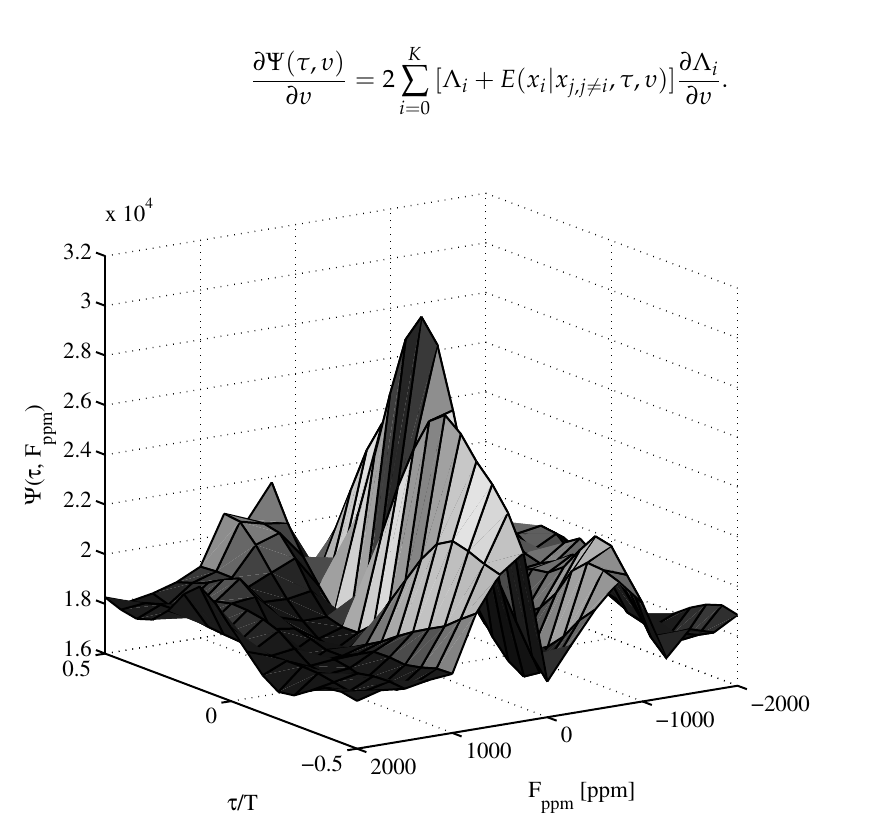
Figure 2. Typical plot of Ψ ( τ , υ ) ( τ , υ ) with LDPC code (1944, 972) by 3 decoding